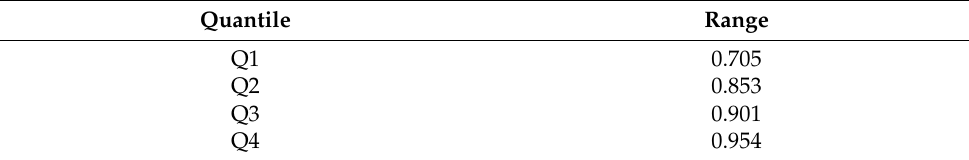
Table 1. Quantiles for the proposed alarm